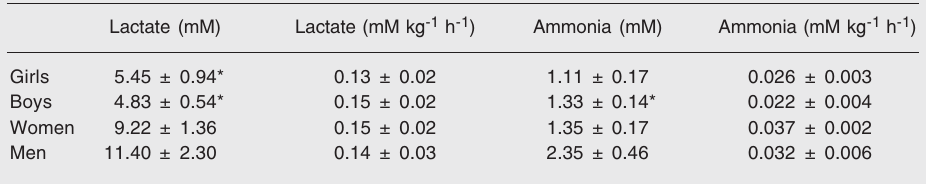
Table 4. Sweat hydrogen (H + ), strong ion difference (SID), osmolality, and sweating rate (SR). H + (mM)